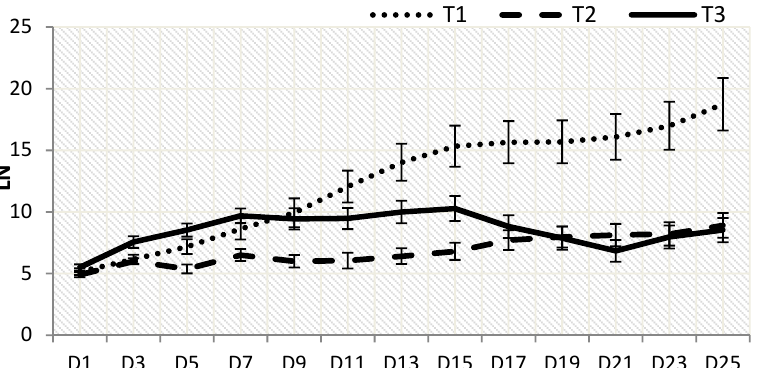
Figure 2. Effect of shading levels on leaves number, LN (Data are means of treatments, N = 96; Rep = 4; Control, T1 = 0% Shading; T2 = 50% Shading and T3 = 70% Shading; Small bars represent standard error).